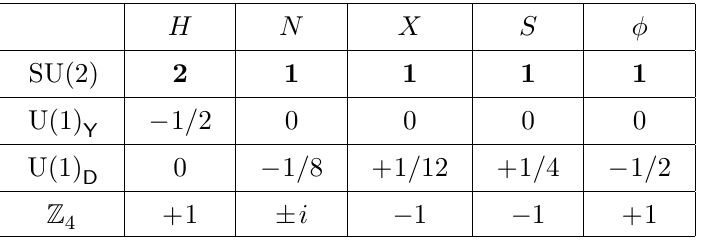
Table 1 . Charge assignments of the fermion and scalars in the a SIMP model, where H is the SM √ Higgs doublet and i = − 1